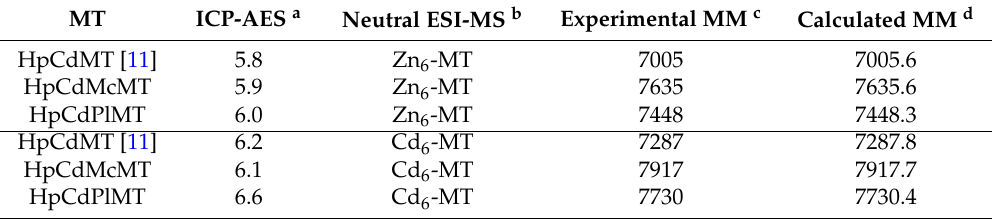
Table 1. Analytical characterization of the recombinant Zn(II)- and Cd(II)-complexes of the HpCdMT mutants studied in this work. For comparative purposes, data for the recombinantly-synthesized wild-type HpCdMT are included [11].